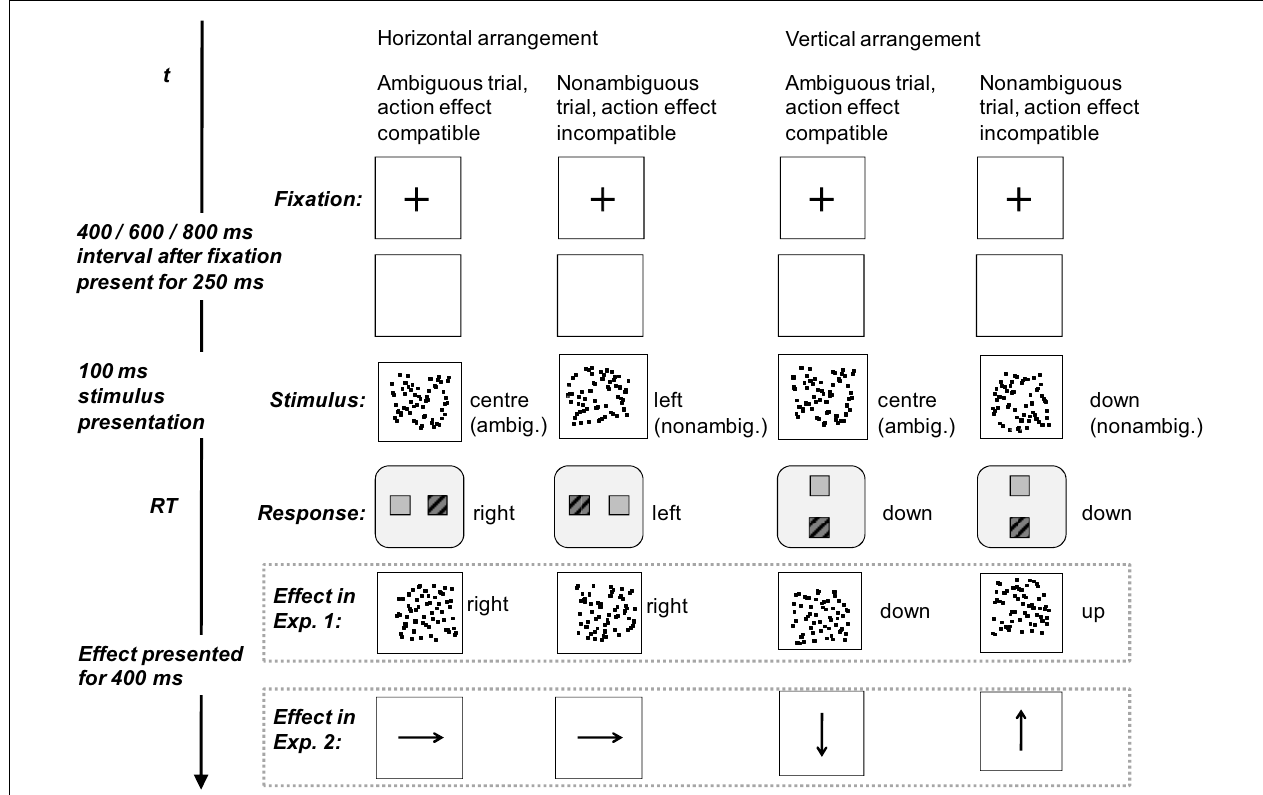
FIGURE 1 | Example stimuli and time-line for Experiment 1. In Experiment 2, arrows were used as action effects instead of clouds of